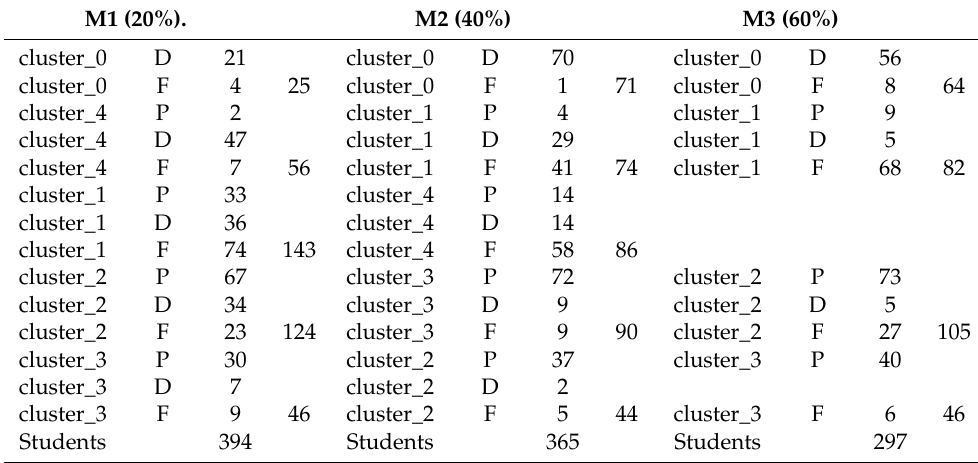
Table 7. Clusters and instances by